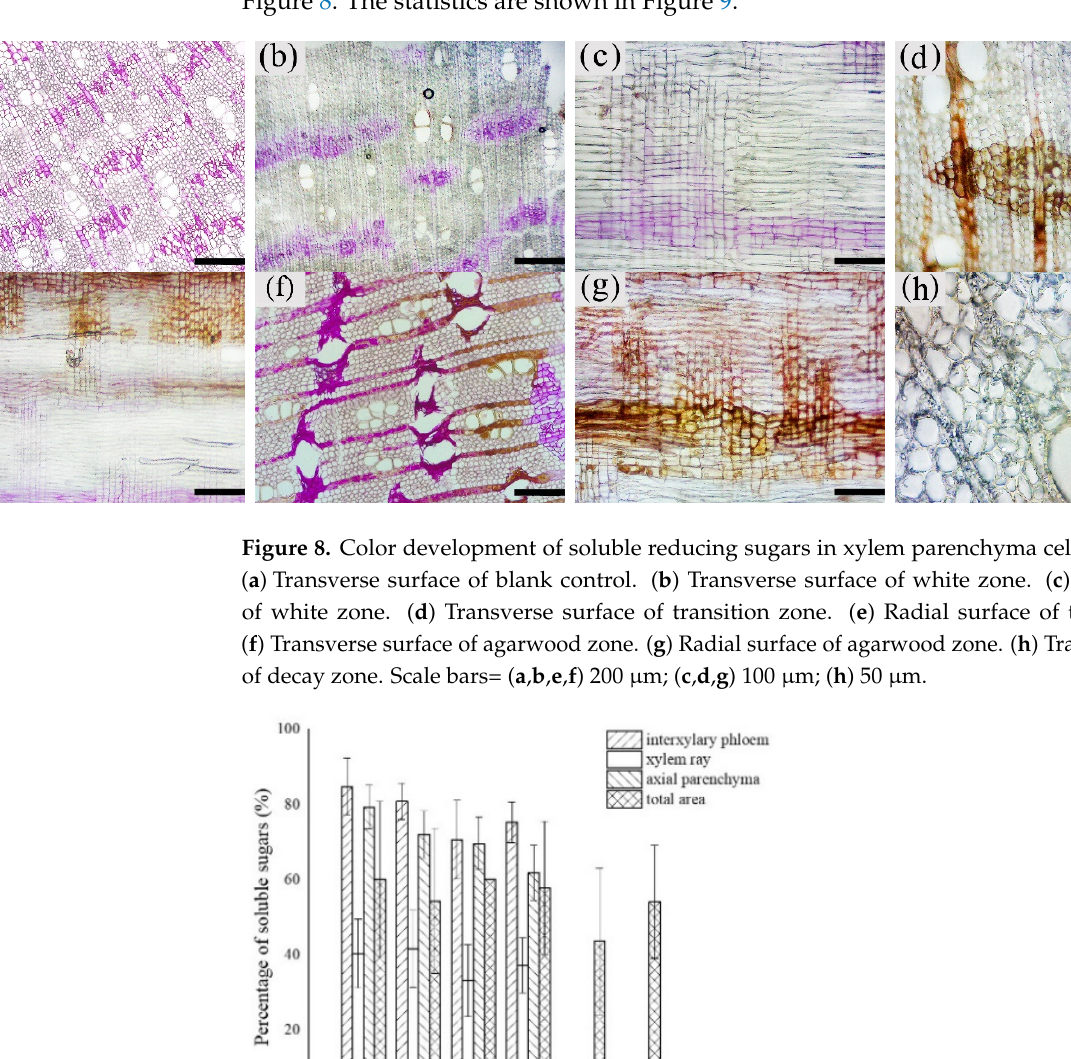
10 of 20 Figure 7. Statistics of color development of starch grains in parenchyma cells. W—white zone; T— transition zone; A—agarwood zone; D—decay zone; 12—inoculated for 12 months; 18—inoculated for 18 months. The soluble sugars staining in different compartments of the xylem is shown in Fig- ure 8. The statistics are shown in Figure 9. The distribution of soluble sugars in the blank control is shown in Figure 8a. The soluble sugars in the white zone were mainly distributed in the axial parenchyma and the interxylary phloem and less in the xylem rays. It was similar to the distribution in the blank control. Approximately 82.82% of the interxylary phloem was purplish-red in the transverse surface (Figure 8b), and approximately 75.68% of the axial parenchyma was stained purplish-red in the radial surface (Figure 8c). The xylem rays were only purplish- red near the interxylary phloem, with a color development rate of approximately 40.99%. In the transition zone, the colored area of the interxylary phloem and axial parenchyma was larger, whereas a small portion of the xylem rays was purplish-red and lighter in color. The purplish-red interxylary phloem was observed on the transverse surface (Fig-